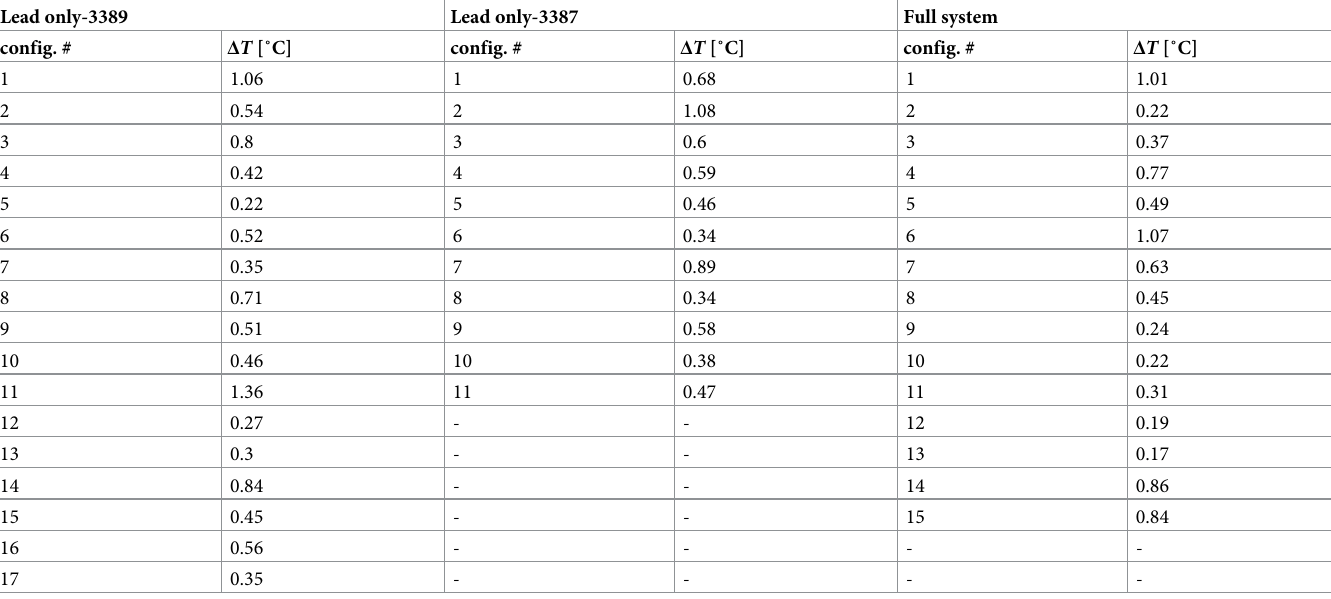
Table 3. Temperature rise for lead-only and full DBS